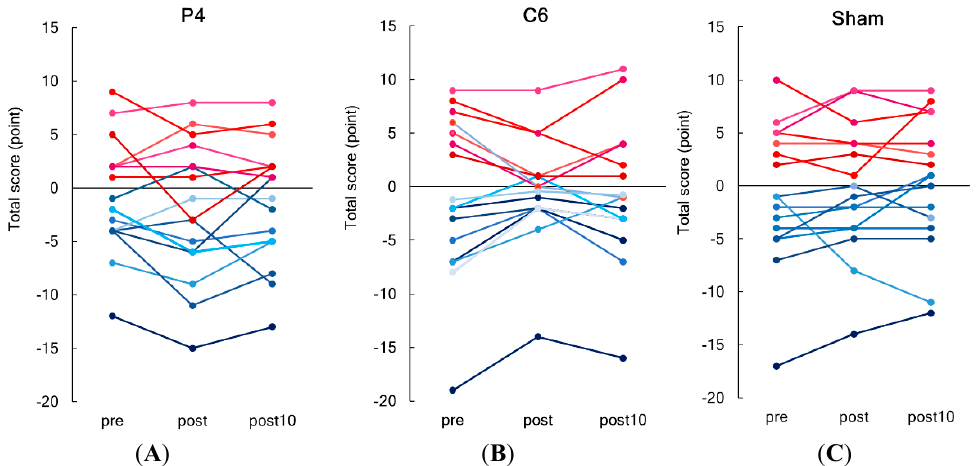
Figure 4. Serial changes in the individual total scores of line length judgement task before (pre), immediately after (post), and 10 min (post 10) after transcranial static magnetic stimulation (tSMS) for 20 min. Scatter plots present the individual values for each stimulation condition: ( A ) P4, ( B ) C6 and ( C ) sham stimulation. Nine subjects showed a rightward bias (reddish lines), and seven subjects showed a leftward bias (blueish lines). Table 2. The total score and the number of errors in the line length judgement task for the left-biased group (mean ± standard error of the mean (SEM)). n = 9. * p < 0.001 vs. pre, † p < 0.05 vs. tSMS over P4. Stim. Site P4